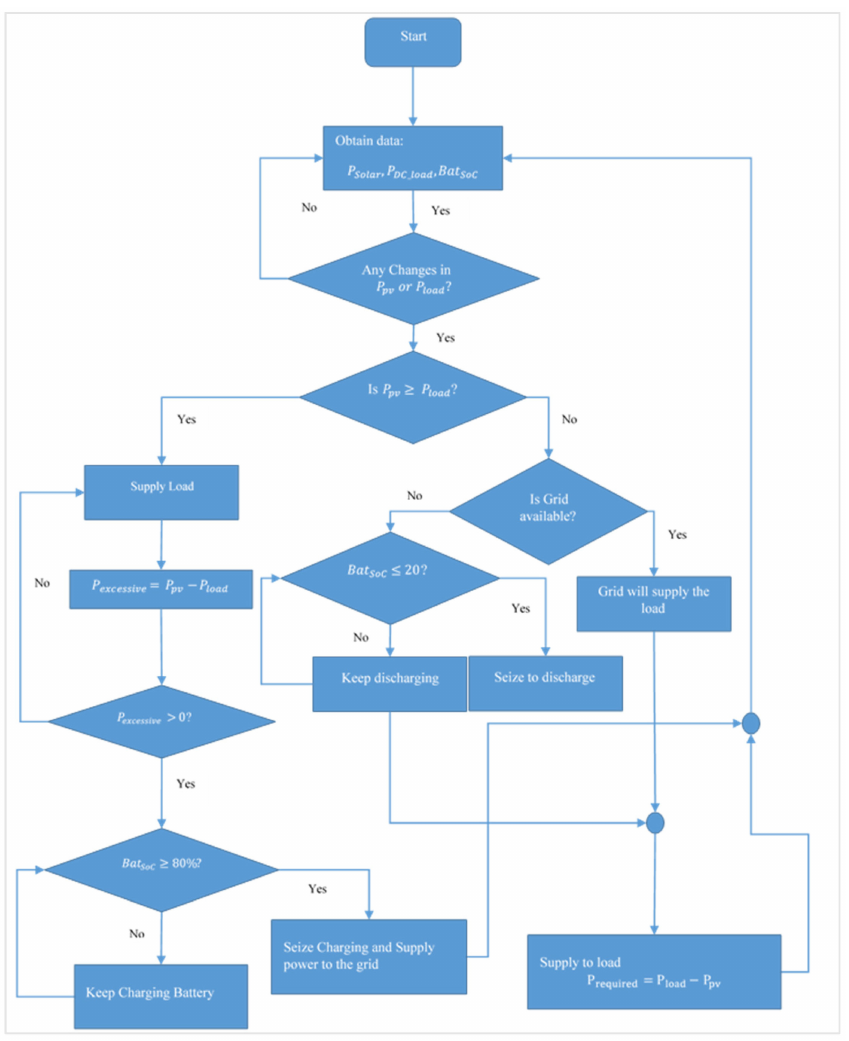
Figure 5. Flow chart—operation of energy sources